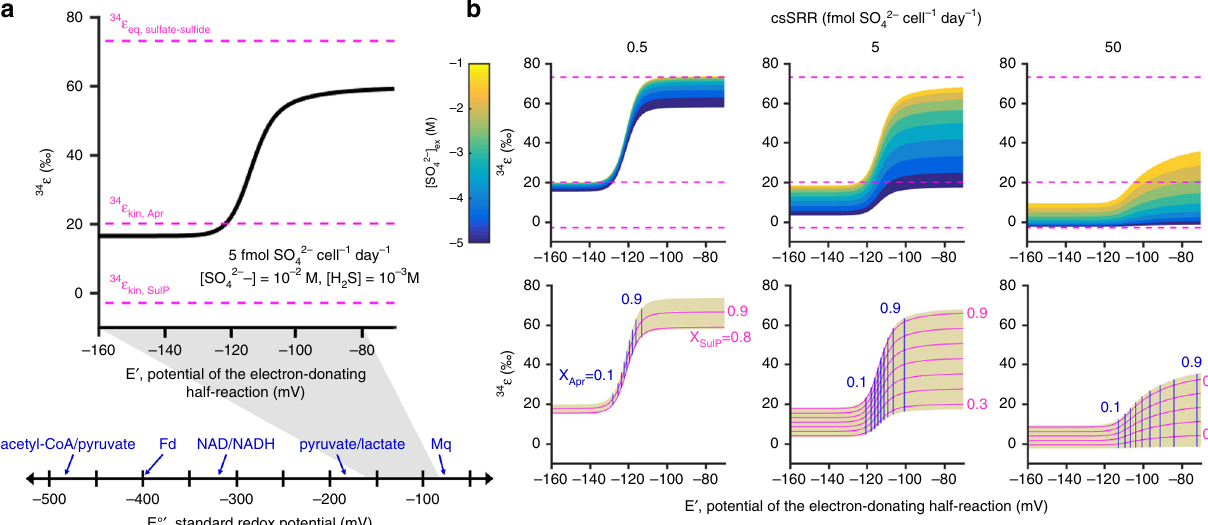
Fig. 3 Predicted pattern of the sulfur isotope fractionation during sulfate reduction. We modify the model of Wing and Halevy 31 to include our new experimental constraint on the sulfur isotope effect of APS reductase. Red broken lines represent the threshold values that de fi ne the allowable range of fractionation. From top to bottom, 34 ε eq, sulfate-sul fi de , 34 ε kin, Apr , and 34 ε kin, SulP denote the equilibrium fractionation between sulfate and sul fi de, the kinetic isotope effect of APS reductase, and the kinetic isotope effect of sulfate permease, respectively. a Sulfur isotope effect as a function of the half-reaction midpoint potential for electron donation to the terminal reductases (Apr and Dsr) under fi xed sulfate concentration and cell-speci fi c sulfate reduction rate (csSRR). Standard redox potentials for common electron donors and carriers are given for the comparison. Fd ferredoxin, Mq menaquinone. b Systematic exploration of the model space by varying sulfate concentrations and csSRRs. Upper panels demonstrate the in fl uence of sulfate and intracellular redox levels on the overall fractionation at three different csSRRs. The lower panels show the reversibilities of sulfate uptake (X SulP ) and APS reduction (X Apr ) steps. Note that as long as the redox potential is negative enough to make the APS reduction practically irreversible, the overall fractionation cannot